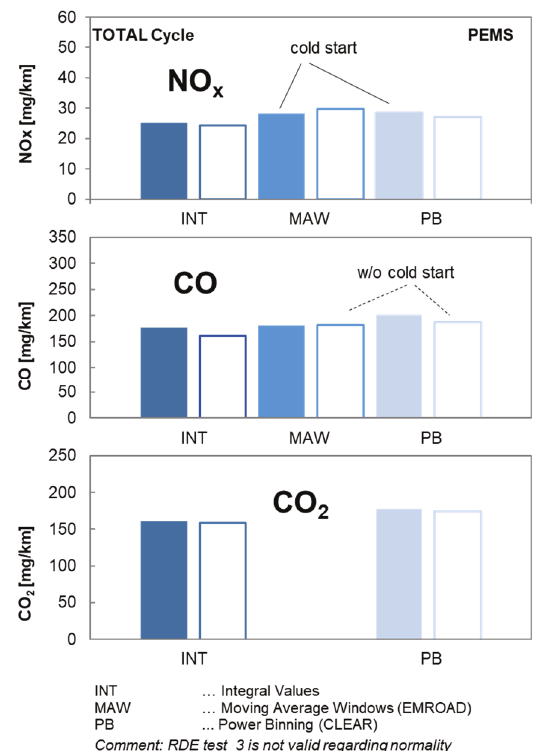
Fig. 12. Comparison of results with and without coldstart RDE - Integral values, MAW and PB; Volvo (V1)